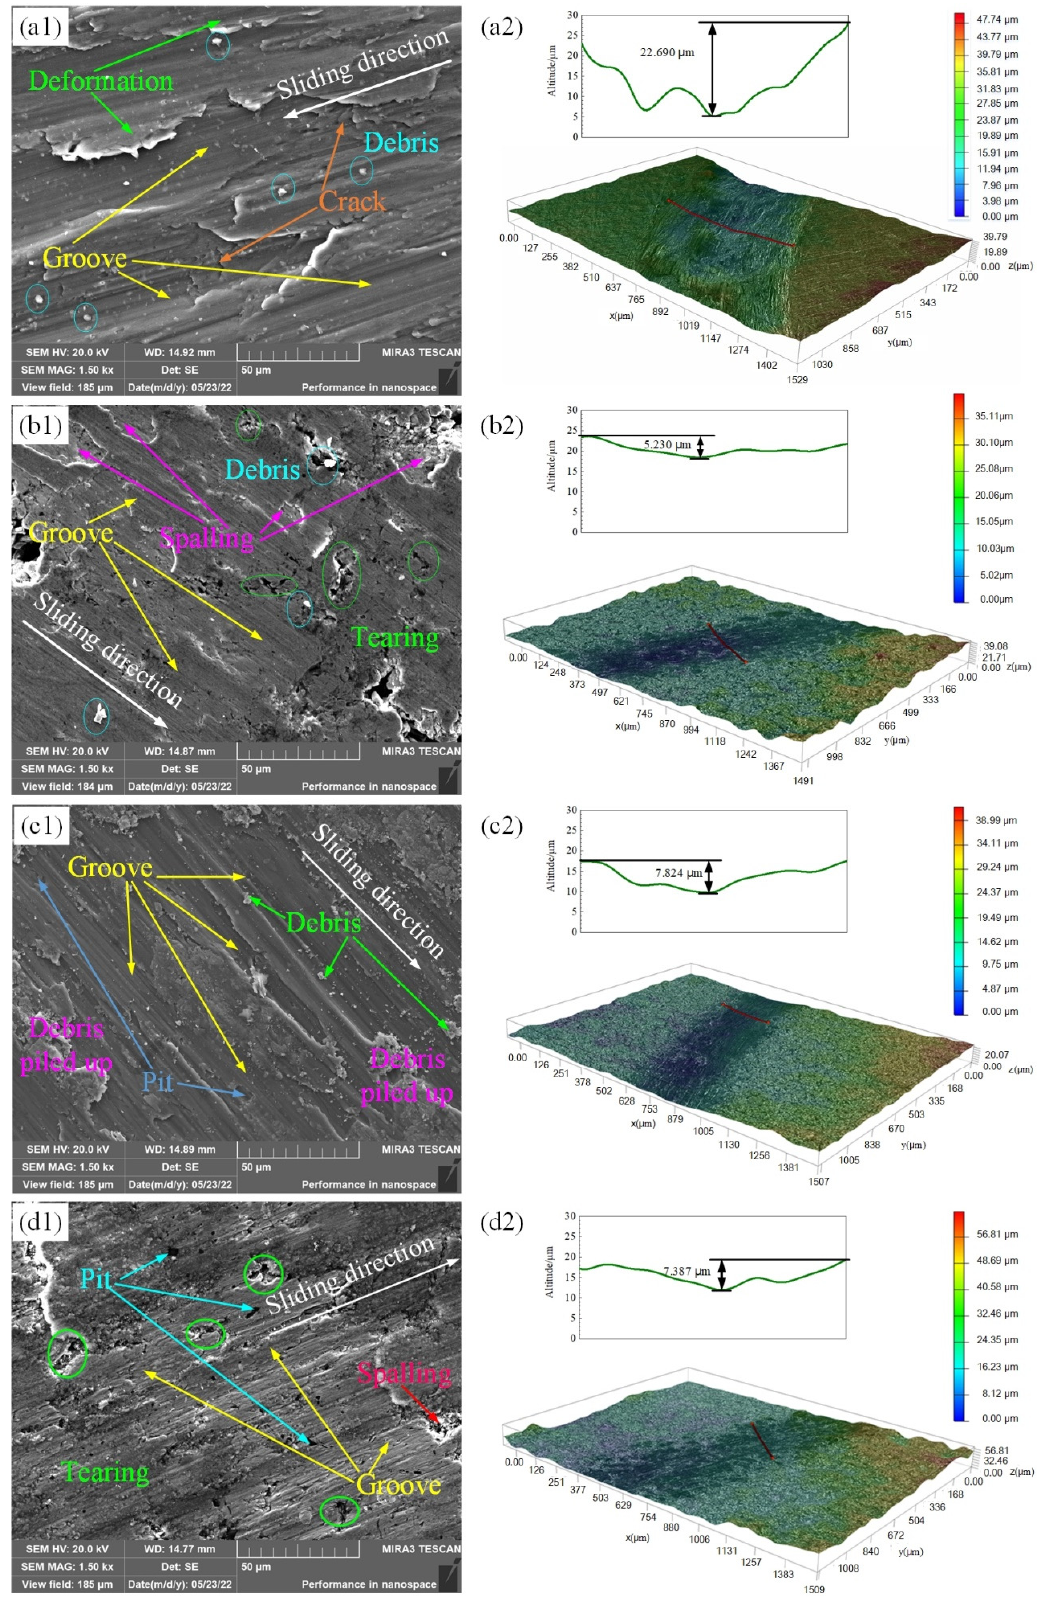
Figure 8. SEM images and 3D morphologies of the worn surface. ( a1 , a2 ) E0 sample; ( b1 , b2 ) E1 sam- ple; ( c1 , c2 ) E2 sample; ( d1 , d2 ) E3 sample.